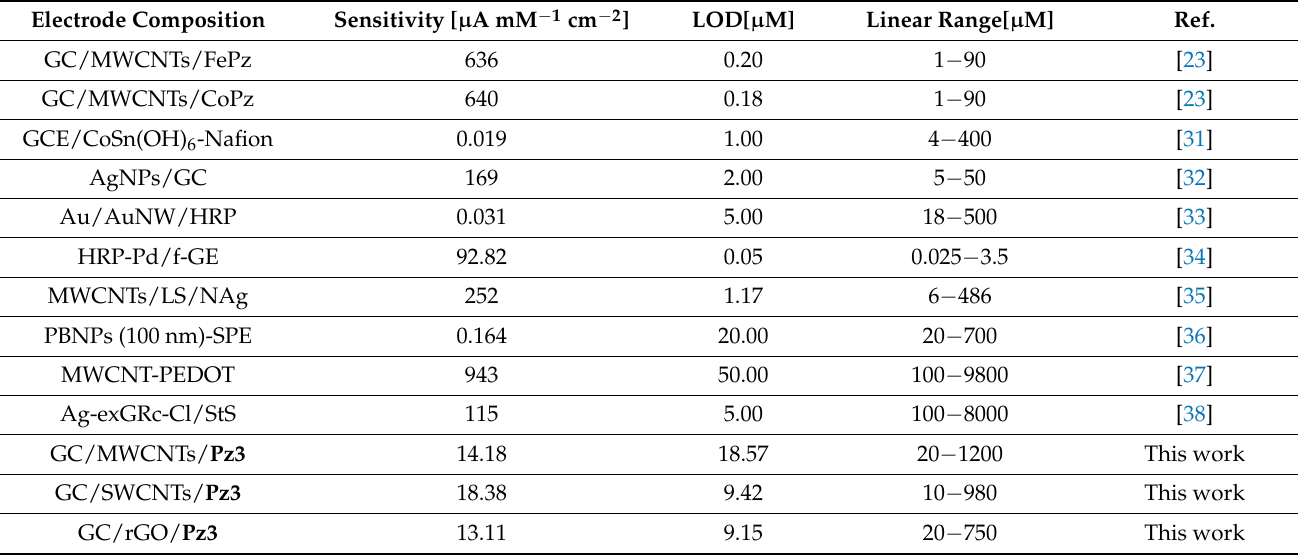
Table 3. Analytical parameters of the studied electrodes as compared to other reported H 2 O 2